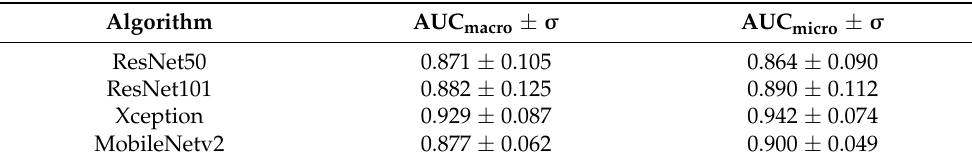
Table 5. Performance of different algorithms using AUC macro and -micro as evaluation metrics along with standard deviation ( σ ).